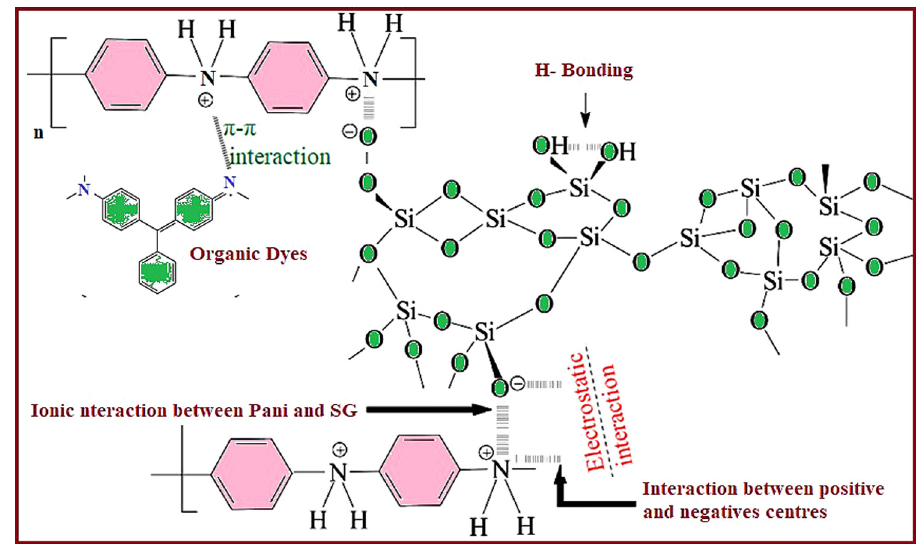
Figure 4: Mechanism of adsorption of organic dyes onto polyaniline - modi fi ed silica gel showing di ff erent